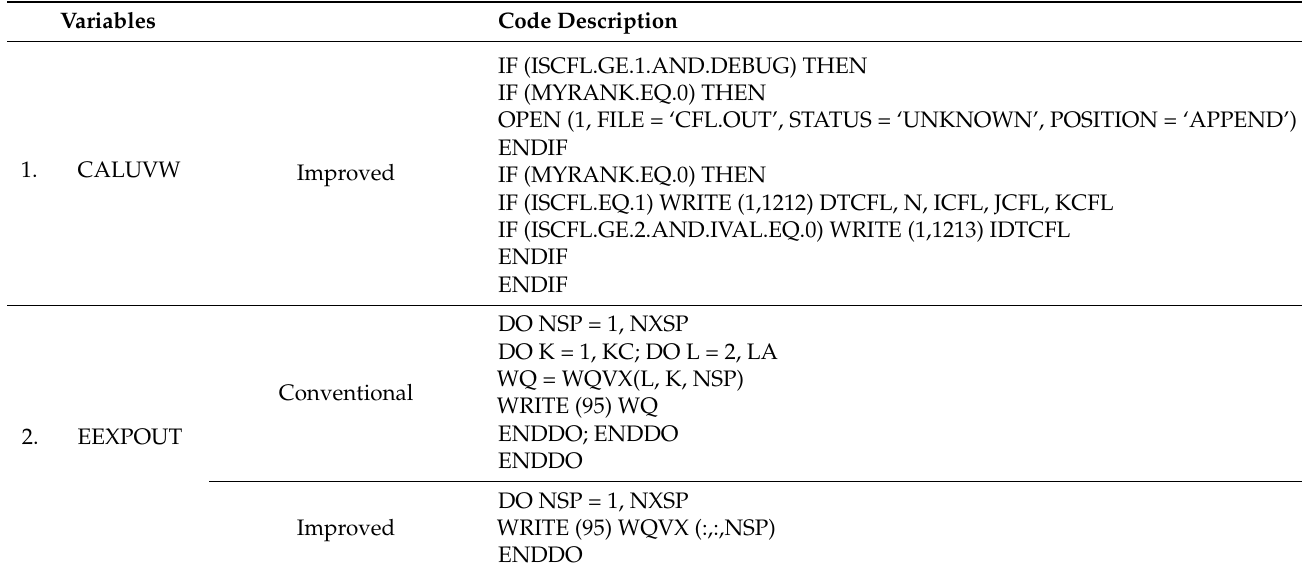
Table A1. Examples of source code